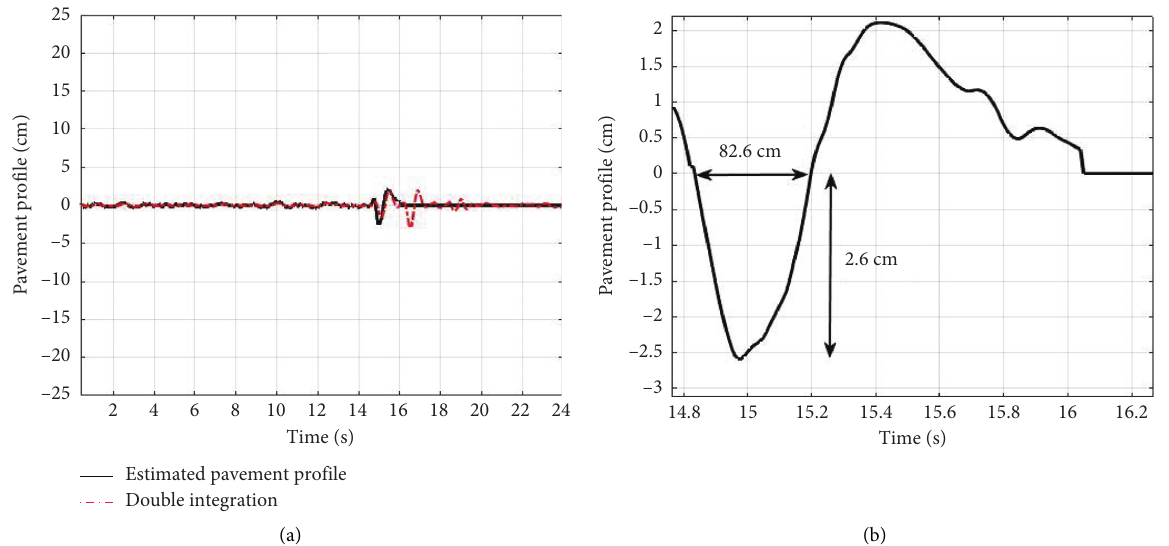
Figure 14: Pavement profile estimation for the pothole. (a) The estimated pavement profile versus double integration (pothole). (b) The estimated geometry